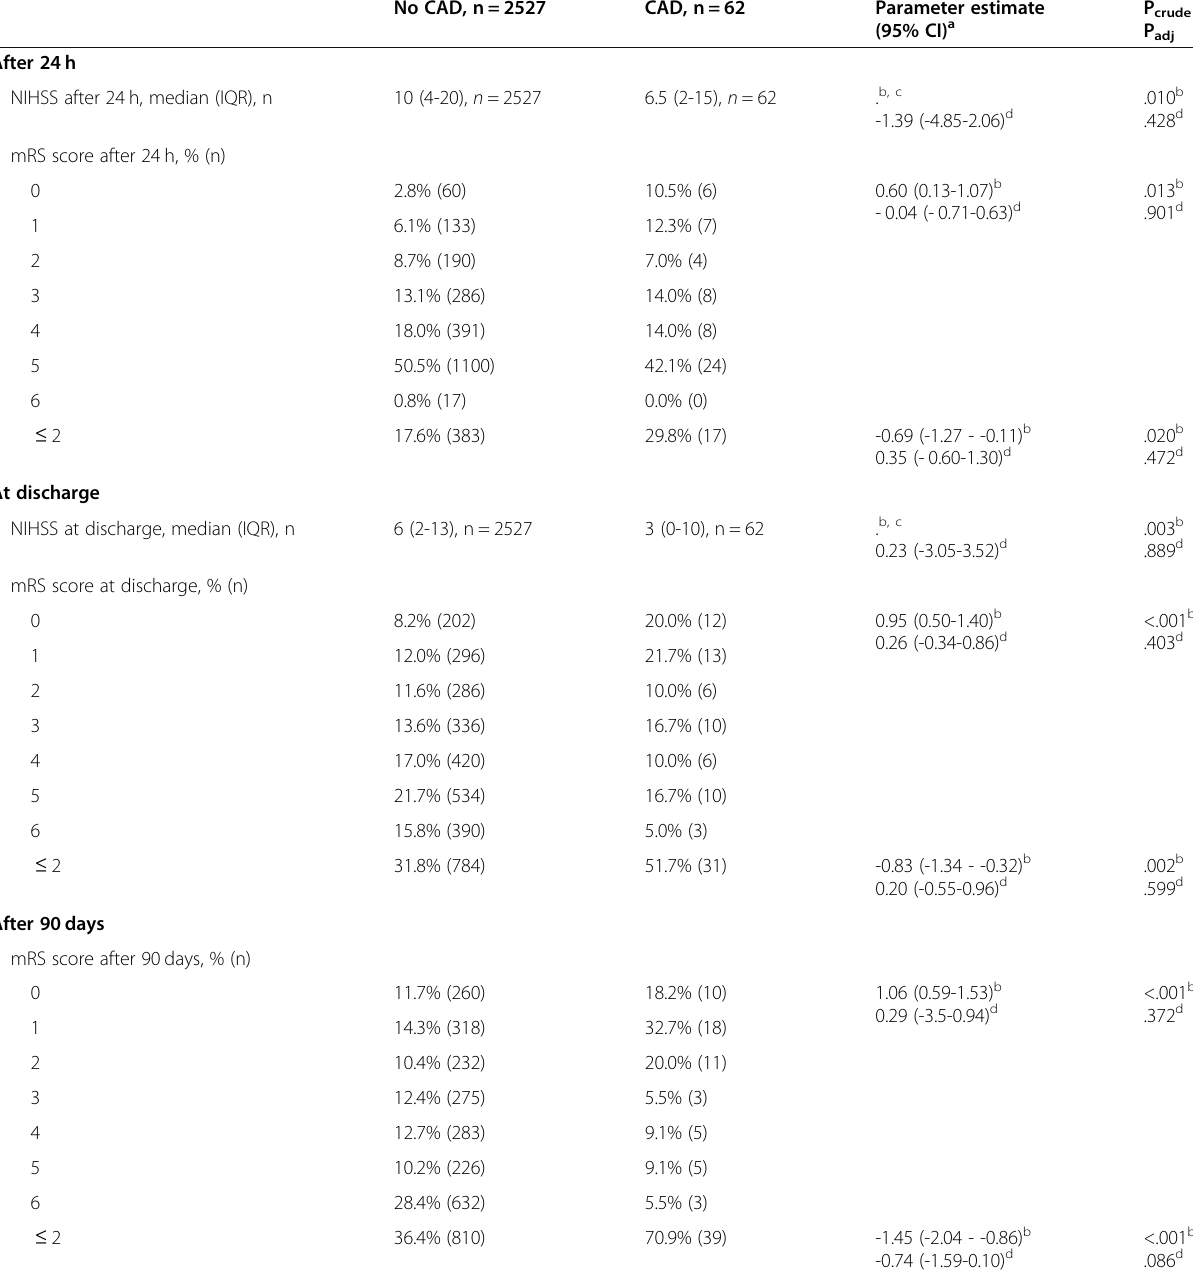
No CAD, n = 2527 CAD, n = 62 Parameter estimate